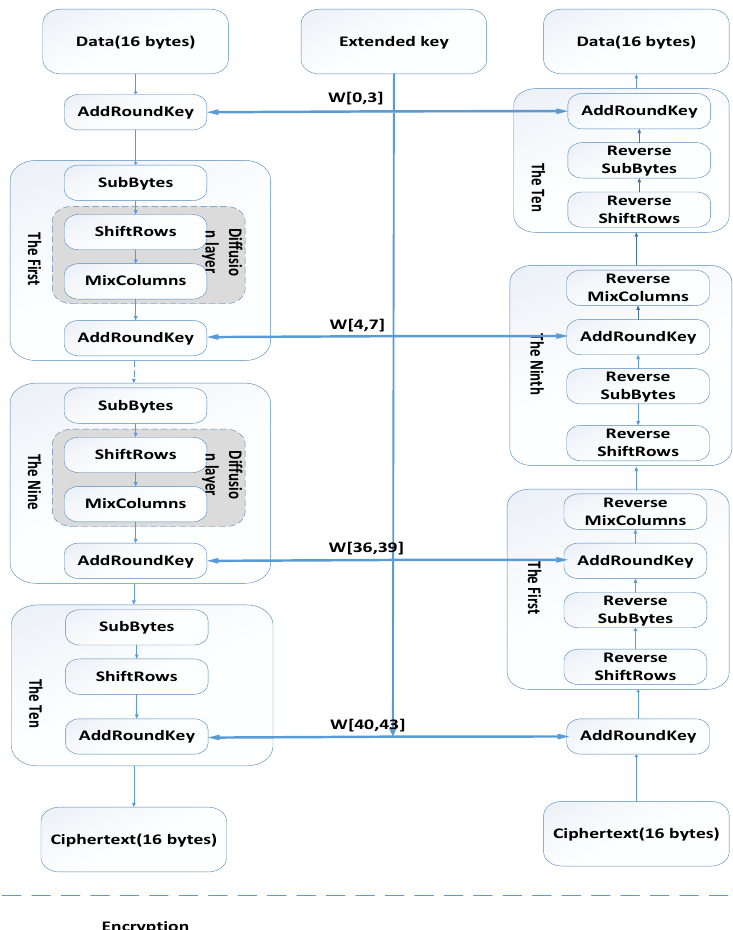
Figure 2. AES algorithm.